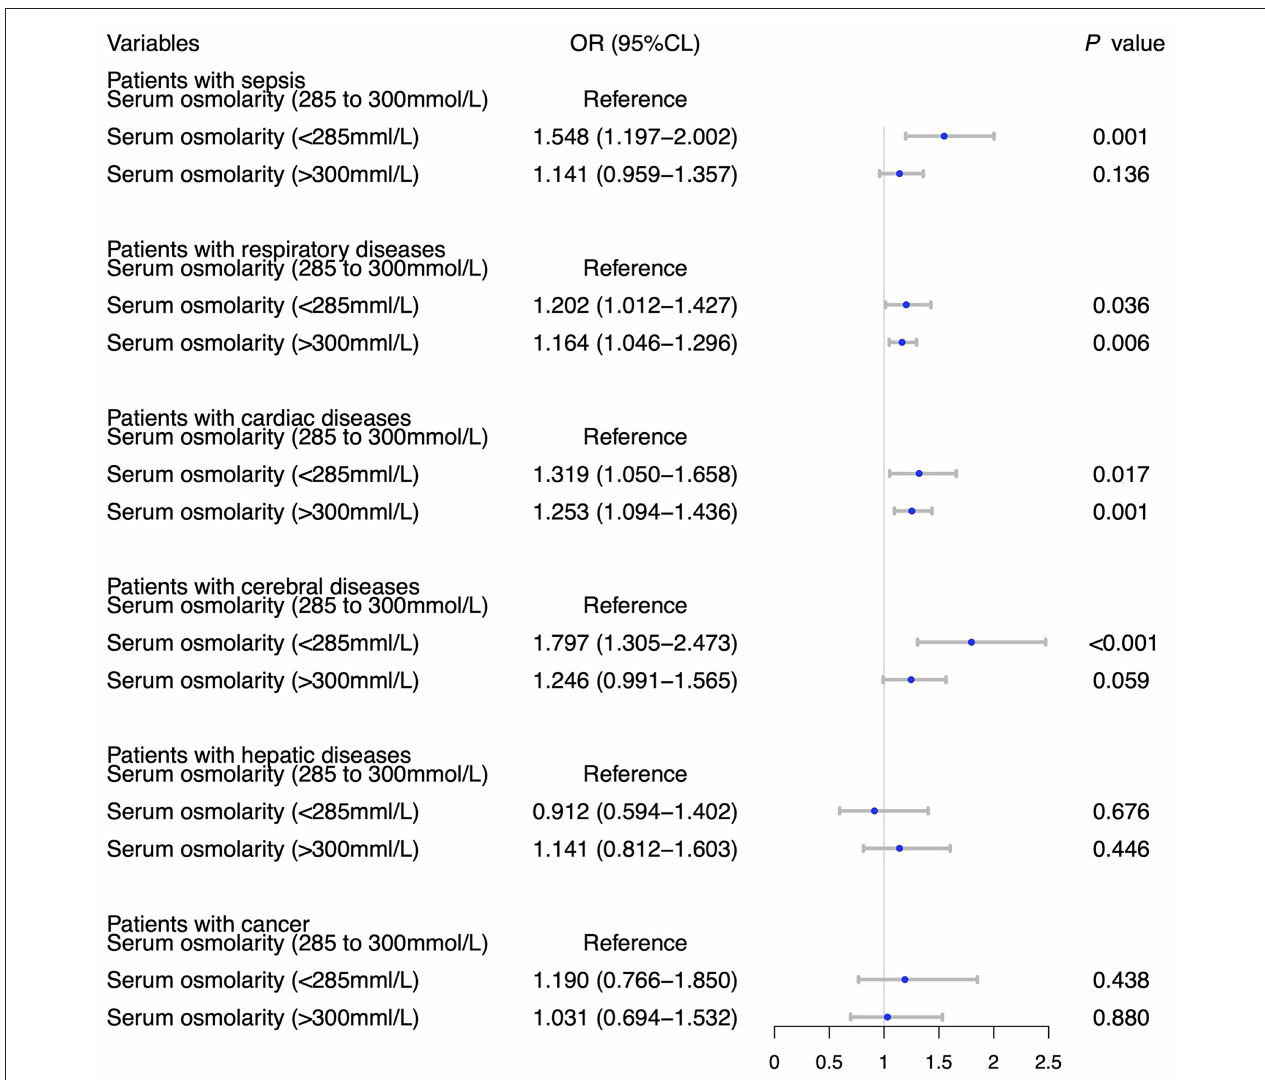
FIGURE 4 | Subgroup analyses on association between serum osmolality and the development of AKI based on causes for ICU admission with adjustment for age, BMI, MAP, temperature, hypertension, diabetes, SOFA, WBC count, platelet count, hemoglobin, use of albumin, and use of norepinephrine.